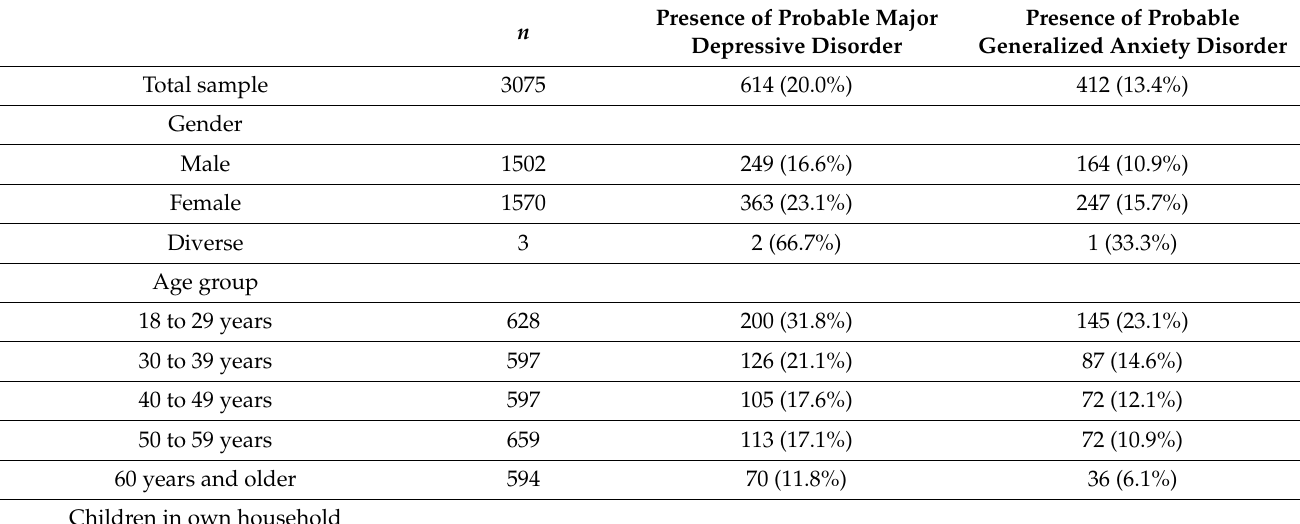
Table 1. Prevalence rate for major depressive disorder and probable generalized anxiety disorder among several